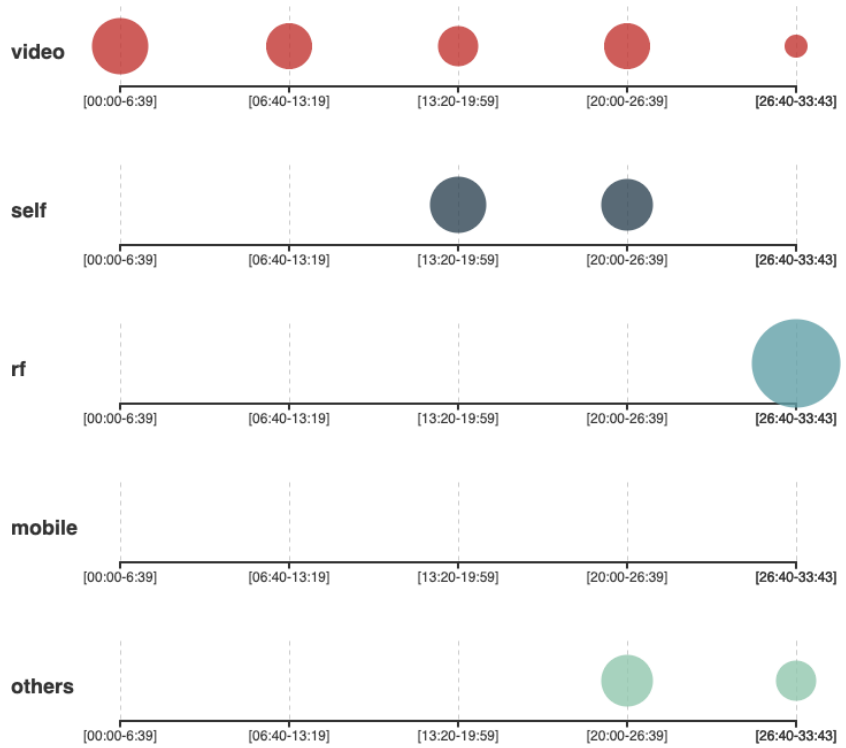
Figure 3. Frequency of mentions to different interaction mechanism by the QOC-FC groups.